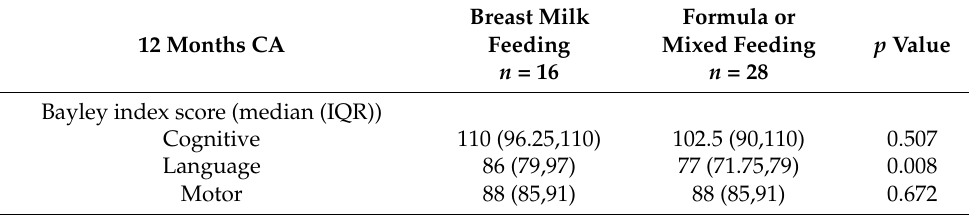
Table 3. Neurodevelopmental outcomes at 12 months CA according to type of toddler